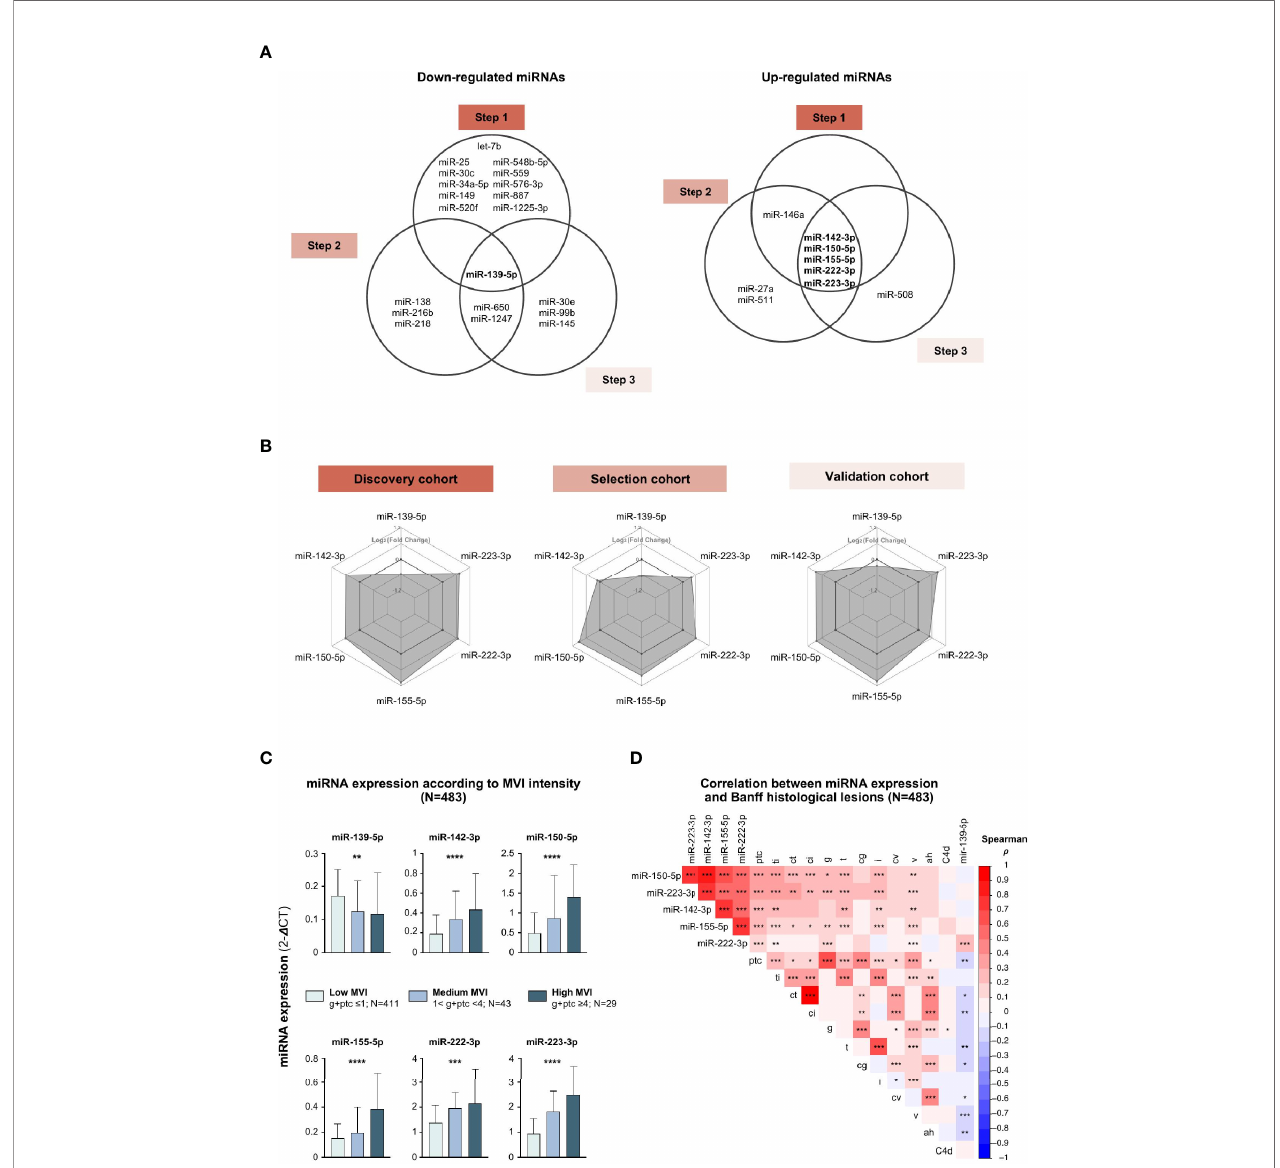
FIGURE 2 | MVI-associated miRNAs pro fi les correlate with histological lesions. (A) Venn diagrams depicting the concordant down-regulated (left) or up-regulated (right) MVI-associated miRNAs across independent cohorts. (B) Radar plots showing similar expression pro fi les of the 6 miRNAs across the 3 cohorts. Each hexagonal line corresponds to a speci fi c differential expression between cases and controls, given as Log 2 (Fold Change). (C) Bar plots showing the expression of individual miRNAs according to MVI intensity with corresponding number of samples. P-values from a Kruskal-Wallis test, *P < 0.05, **P < 0.01, ***P < 0.001. (D) Correlogram of the 6 miRNAs expression and Banff histological lesions using Spearman correlation (**P < 0.01, ***P < 0.001, ****P < 0.0001). Colors indicate correlation coef fi cient ( r ).ah, arteriolar hyalinosis; cg, chronic glomerulopathy; ci, interstitial fi brosis; ct, tubular atrophy; cv, chronic vasculopathy; i, interstitial in fl ammation; ptc, peritubular capillaritis; ti, total in fl ammation; v,